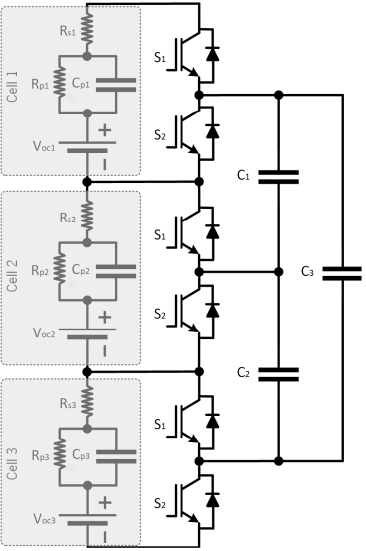
Figure 5. Double-tiered switched-capacitor converter.